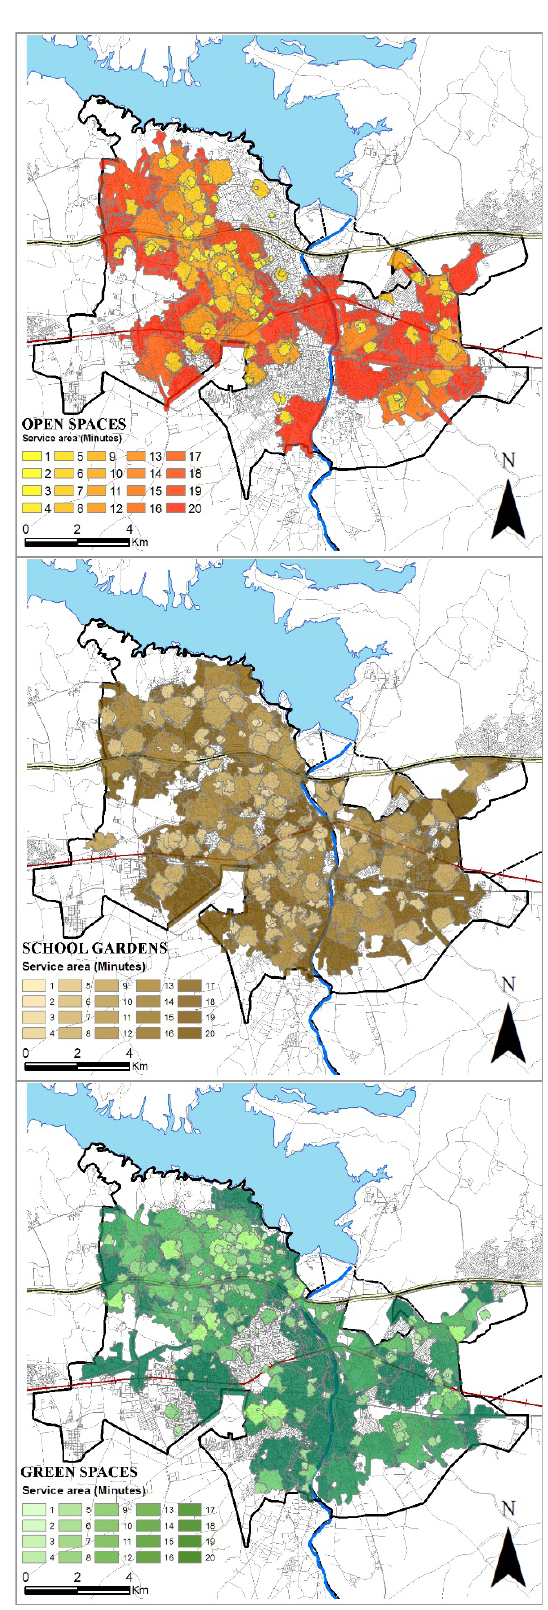
Figure 5: The service areas of